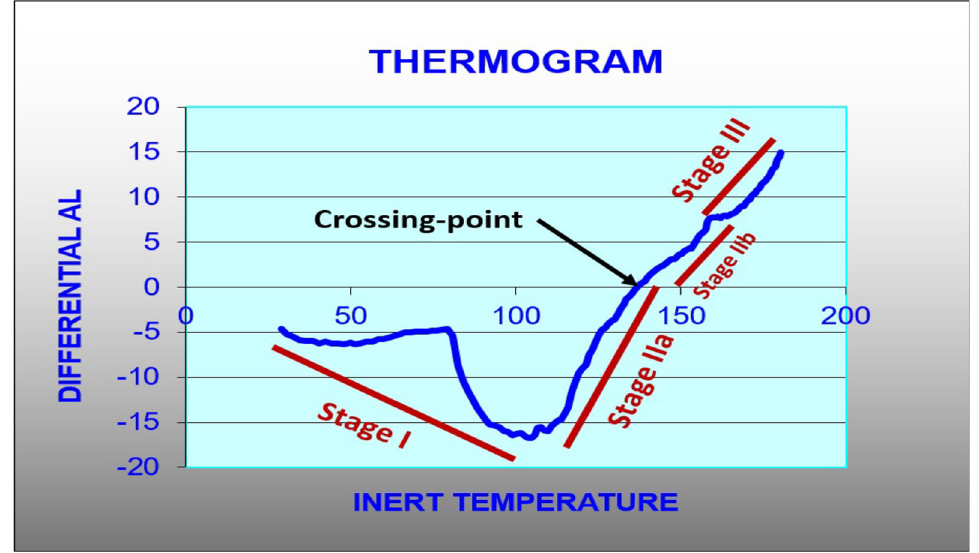
Fig. 4 A characteristic differential analysis thermogram of a coal (Onifade and Genc 2018e)